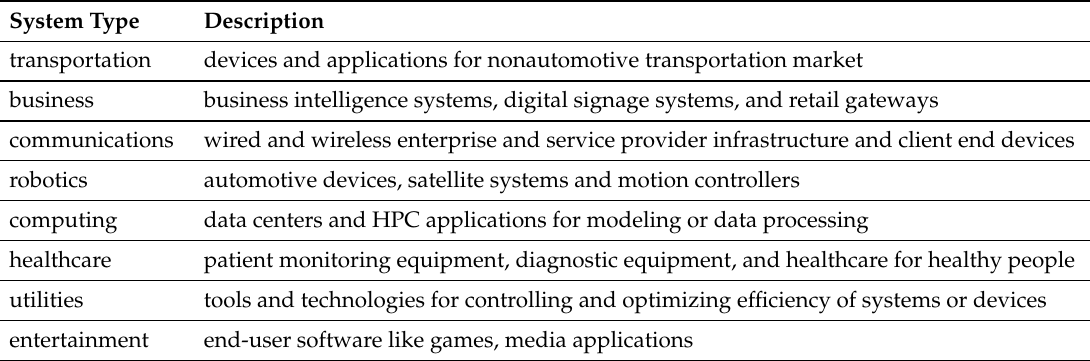
Table 1. System function taxonomy for the computer systems.